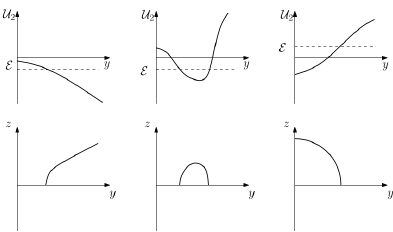
Fig. 3. Solution curves in ( y, z ) -space associated to potential energies U 2 for the different cases ( from left to right ) µ v >